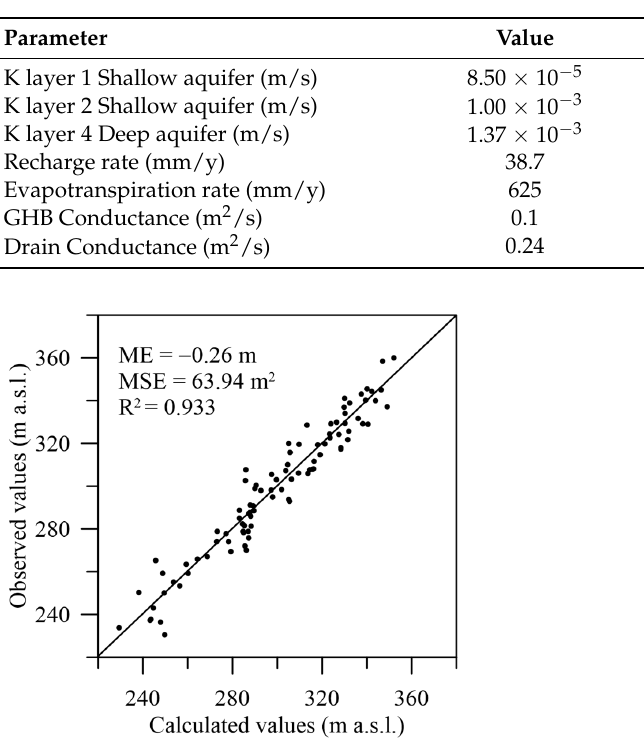
Table 2. Calibrated parameters values and their composite sensitivity via PEST.